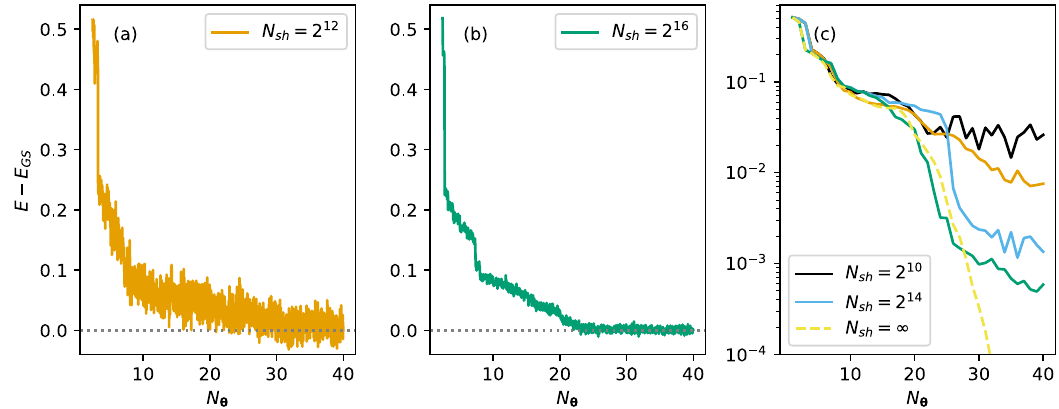
Fig. 5 Energy convergence of qubit adaptive derivative-assembled pseudo-trotter (ADAPT) simulations for e g model with shot noise. The difference between the exact ground state energy E GS and that of qubit-ADAPT simulations with sampling noise was obtained with a number of shots N sh = 2 12 in panel ( a ) and N sh = 2 16 in panel ( b ). Panel c shows the energy differences evaluated using statevector for the adaptive ansätze obtained in simulations including shot noise, with N sh = 2 10 (black line), 2 12 (orange line), 2 14 (sky blue line), and 2 16 (bluish green line). The statevector simulation results ( N sh = ∞ , yellow line) of the qubit-ADAPT algorithm are also shown in a dashed line for reference. Hamiltonian parameters are identical to those used in Fig.